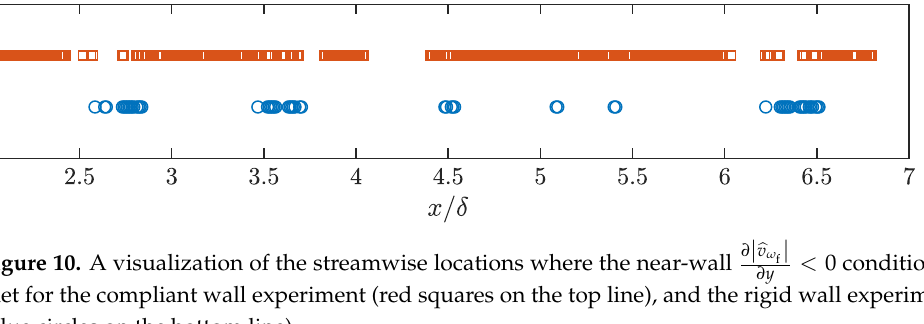
Figure 10. A visualization of the streamwise locations where the near-wall met for the compliant wall experiment (red squares on the top line), and the rigid wall experiment (blue circles on the bottom